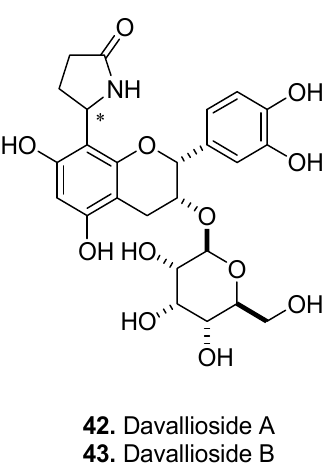
Figure 16. Davallioside A ( 42 ) and Davallioside B ( 43